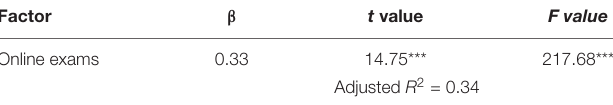
TABLE 5 | Results of simple linear